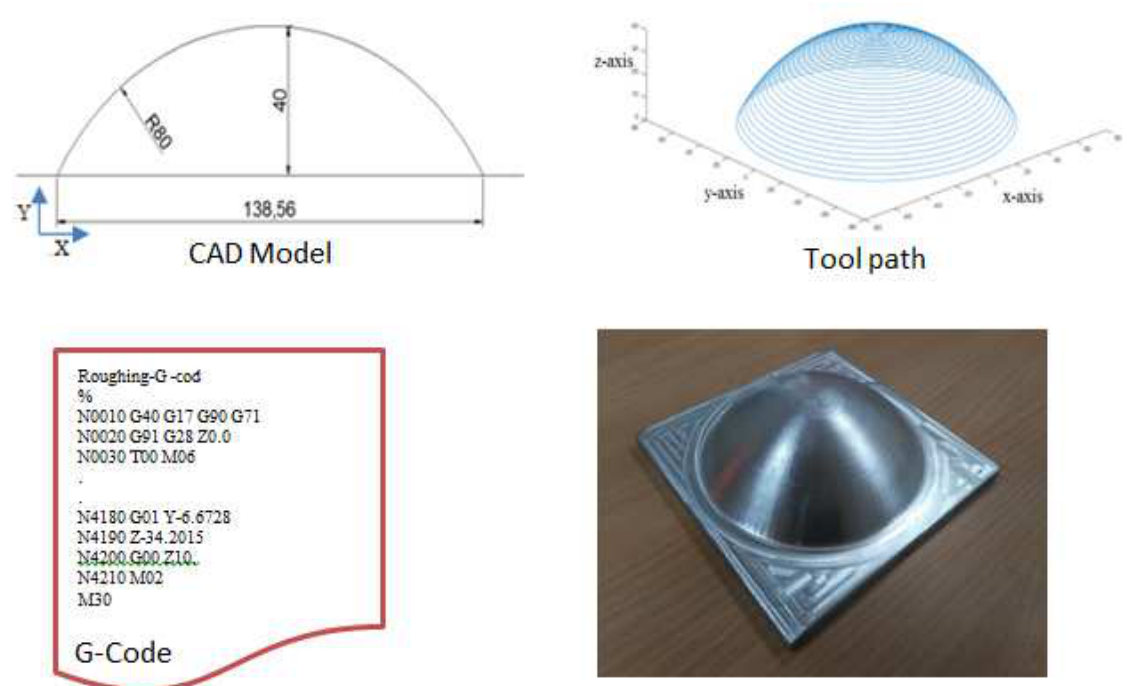
Fig. 3. Geometry of part and CNC-part program. (all dimension in (mm)).